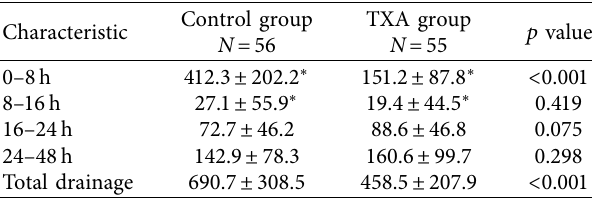
Table 2: Closed-suction drainage